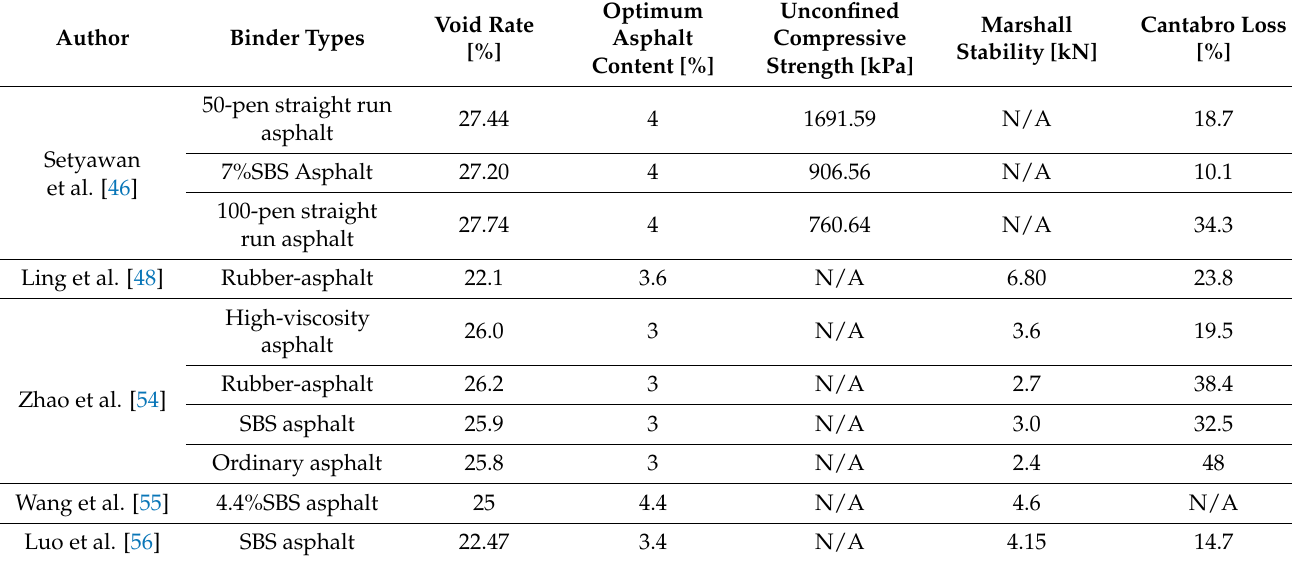
Table 5. Optimal binder and high-temperature performance of